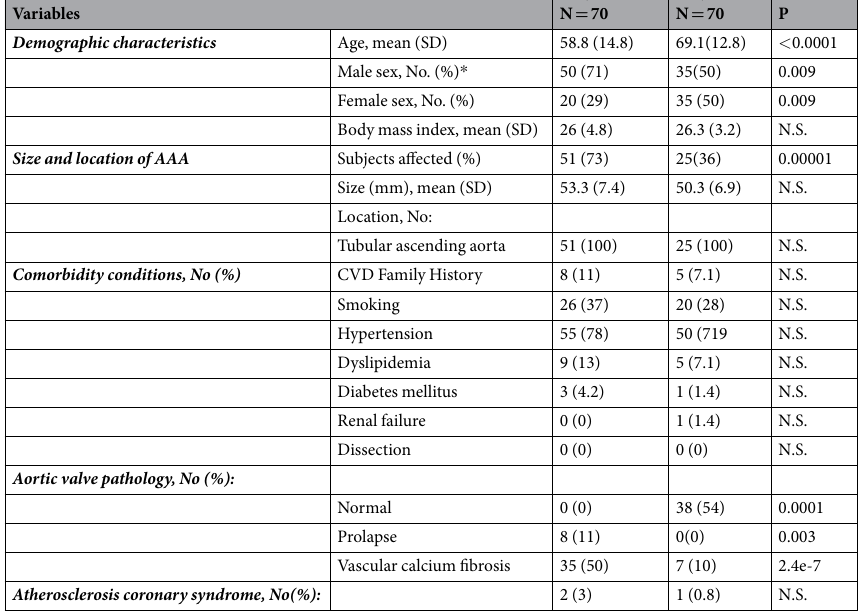
Table 1. Demographic and clinical characteristics, comorbodity conditions, complications of 70 BAV and 70 TAV subjects. * Percentage values on total BAV and TAV subjects . P = TAV vs. BAV, by t Student test for quantitative variables, or χ 2 test for qualitative variables